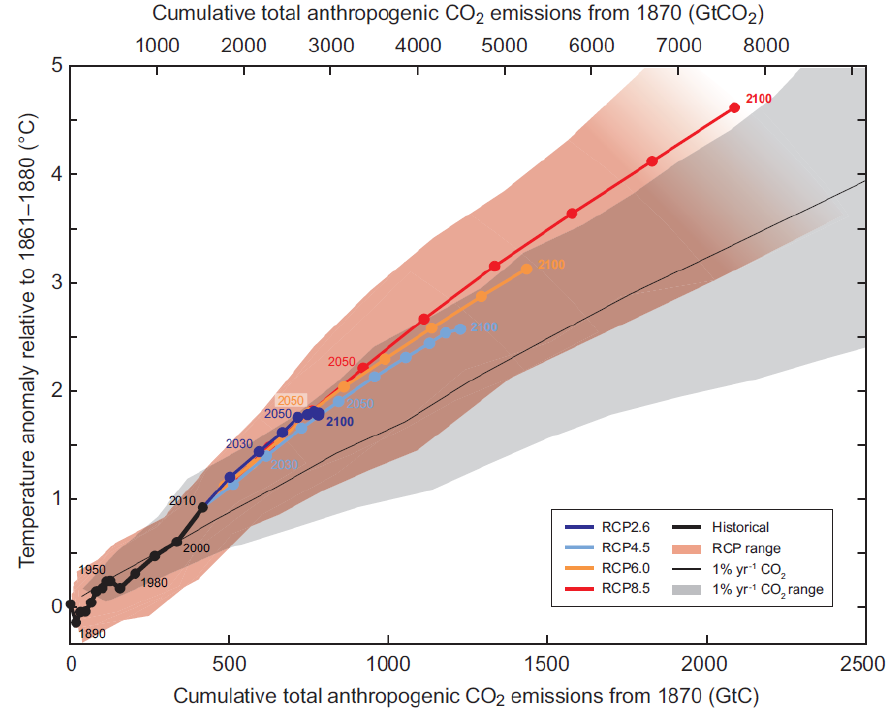
emissions from 1870 to 2100 2